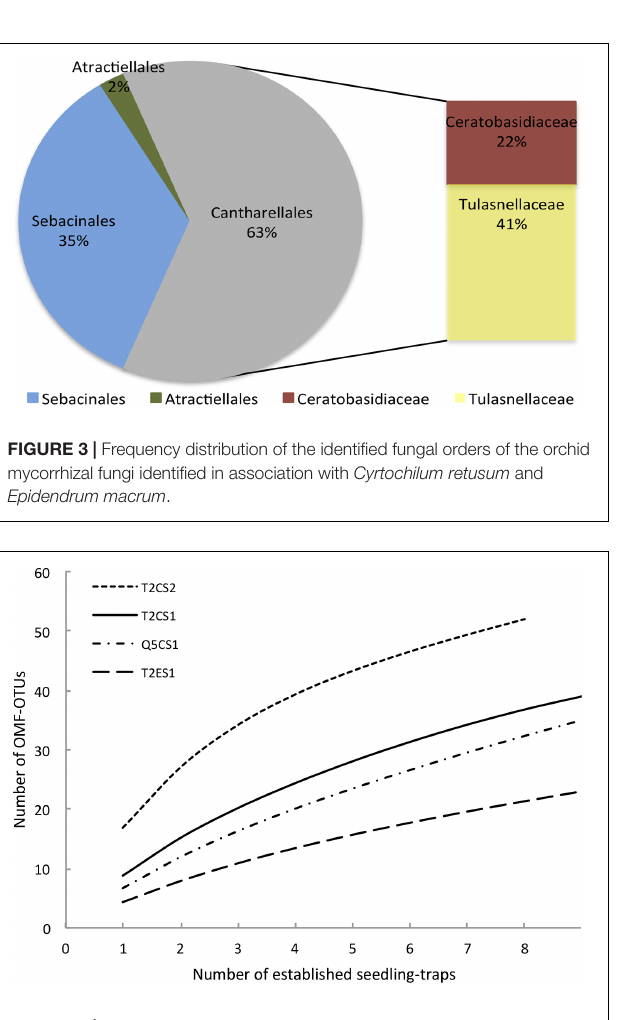
FIGURE 4 | Rarefaction curves of orchid mycorrhizal fungi OTU (operational taxonomic unit) richness in four treatments of field experiment. T2: